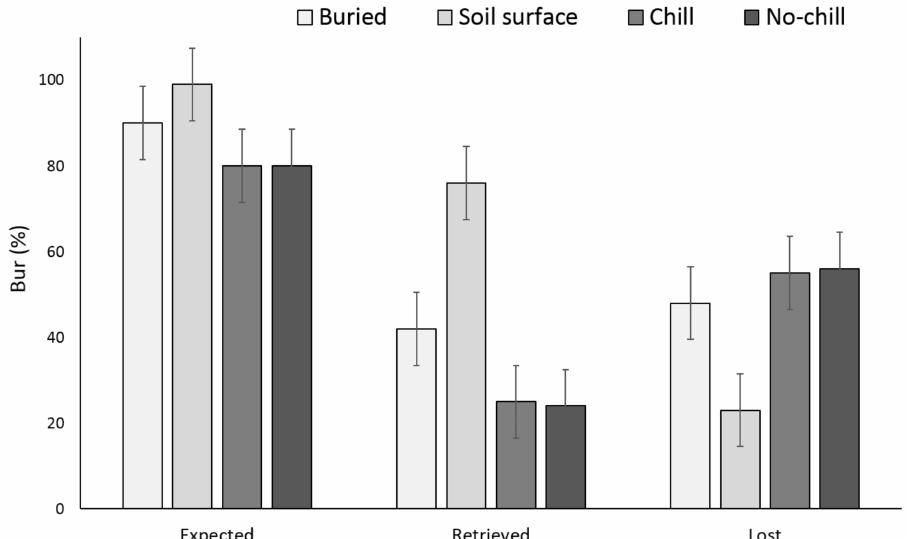
Figure 7. Effect of environmental conditions on X. strumarium bur loss originating from a multiple maternal source after two years. Vertical bars represent LSD at 5% significance level. Expected” is the sum of non-germinated seeds.